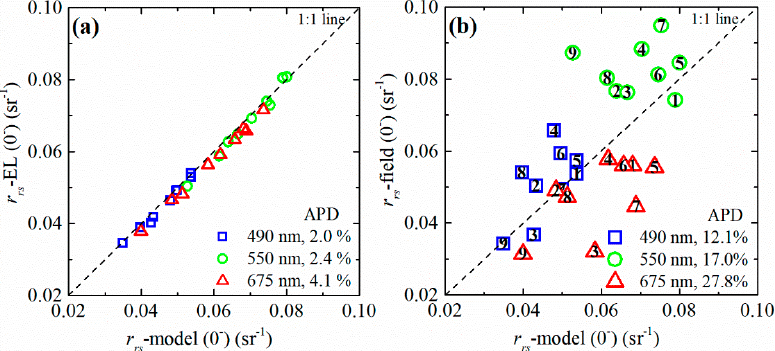
Figure 13. Validation of stratified r rs model using field-measured data (N = 9) of Lake Chaohu on May 28, 2013. Comparison of r rs -model(0 − ) with ( a ) Ecolight-simulated r rs -EL(0 − ), and ( b ) field-measured r rs -field(0 − ) at 490, 550, and 675 nm. Note that the model parameters were obtained from Table 3 according to the sampling time and location.